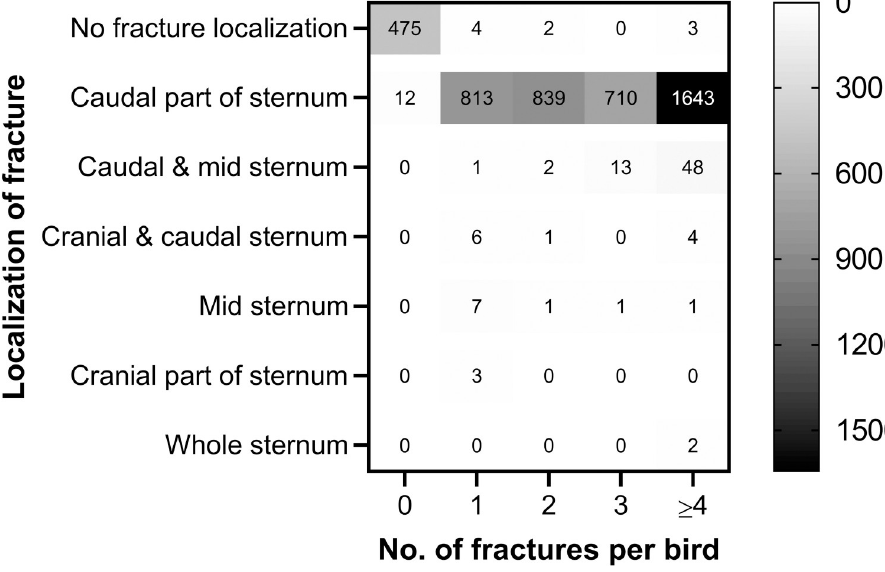
Fig 2. Heat map of the localization of KBF in relation to how many fractures detected in each hen (n = 4591). Values in the heat map cells represent the hen count.